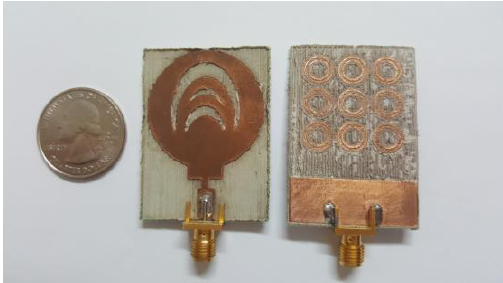
Figure 26. Circular microstrip antenna with C-SRR on the back.